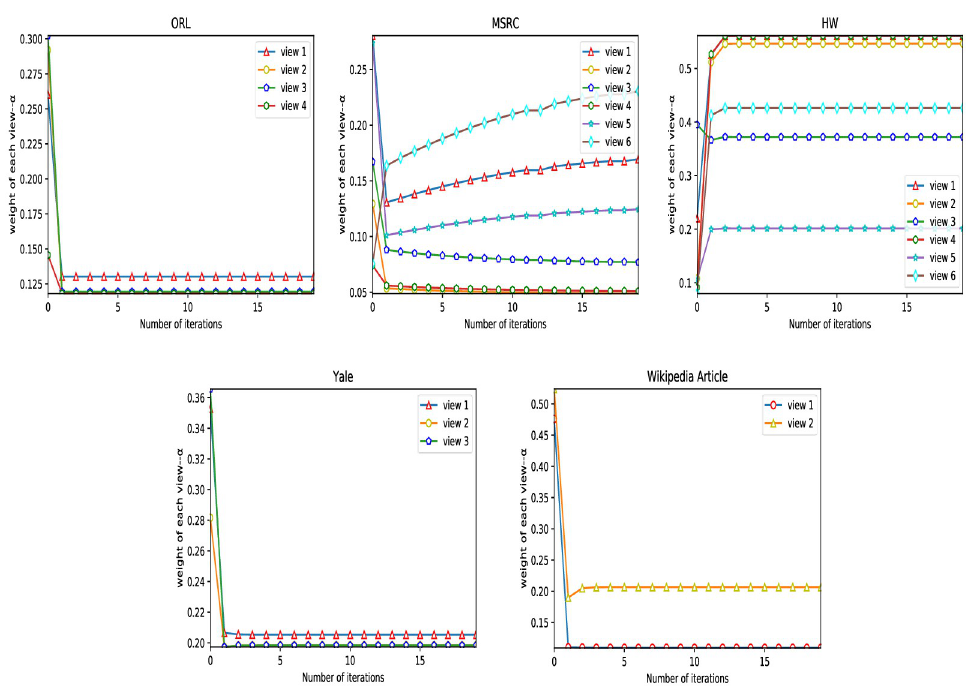
Fig 8. The change of the weight α ( v ) of each view on the five datasets in the RMVCP-2 process.